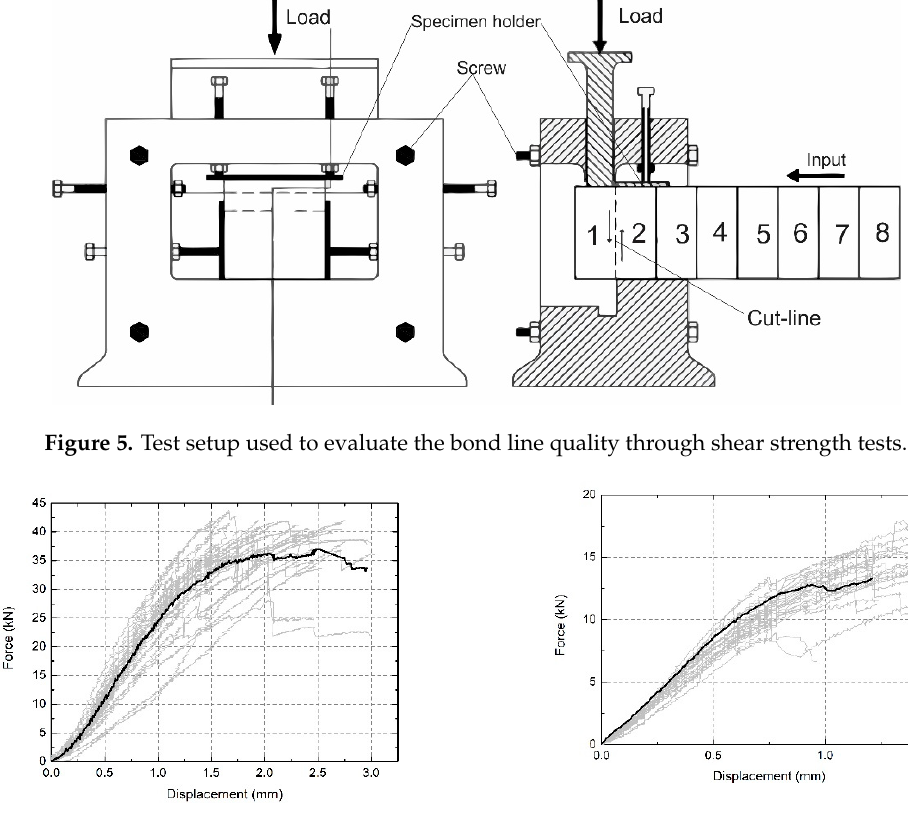
Figure 5. Test setup used to evaluate the bond line quality through shear strength tests.